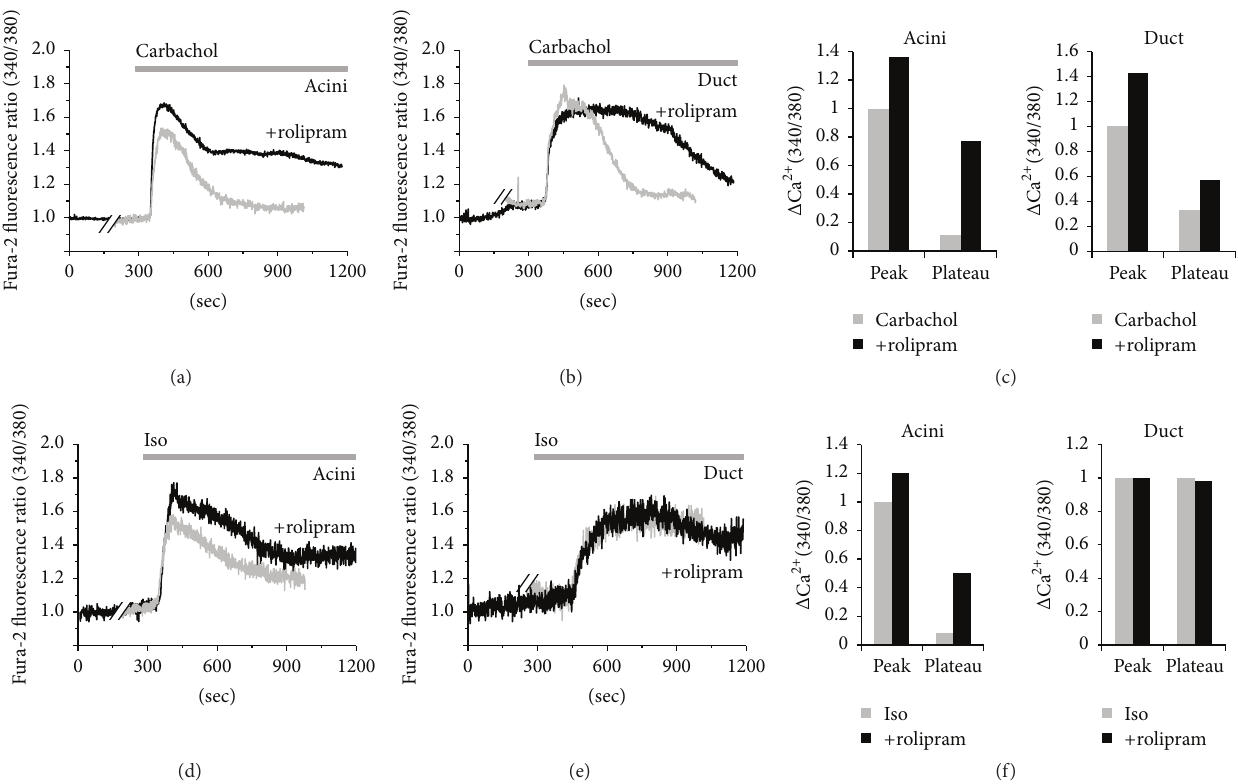
Figure 4: Effect of rolipram on synergistic regulation of cholinergic and 𝛽 -adrenergic stimulation in SMG cells. Changes in [ Ca 2+ ] i induced by 10 𝜇 M carbachol (gray trace) and pretreatment with 10 𝜇 g/mL rolipram (black trace) in SMG acinar (a) and ductal (b) cells. (c) Analysis of carbachol-induced maximum [ Ca 2+ ] i peak and plateau from baseline as determined using R340/380 fluorescence ratios in acini and ductal cells. Changes in [ Ca 2+ ] i induced by 100 𝜇 M isoproterenol (gray trace) and pretreatment with 10 𝜇 g/mL rolipram (black trace) in SMG acinar (d) and ductal (e) cells. All traces were averaged. (f) Analysis of isoproterenol-induced maximum [ Ca 2+ ] i peak and plateau from baseline as determined using R340/380 fluorescence ratios in acini and ductal cells. The upper bars indicate the extracellular solutions applied to the cells.